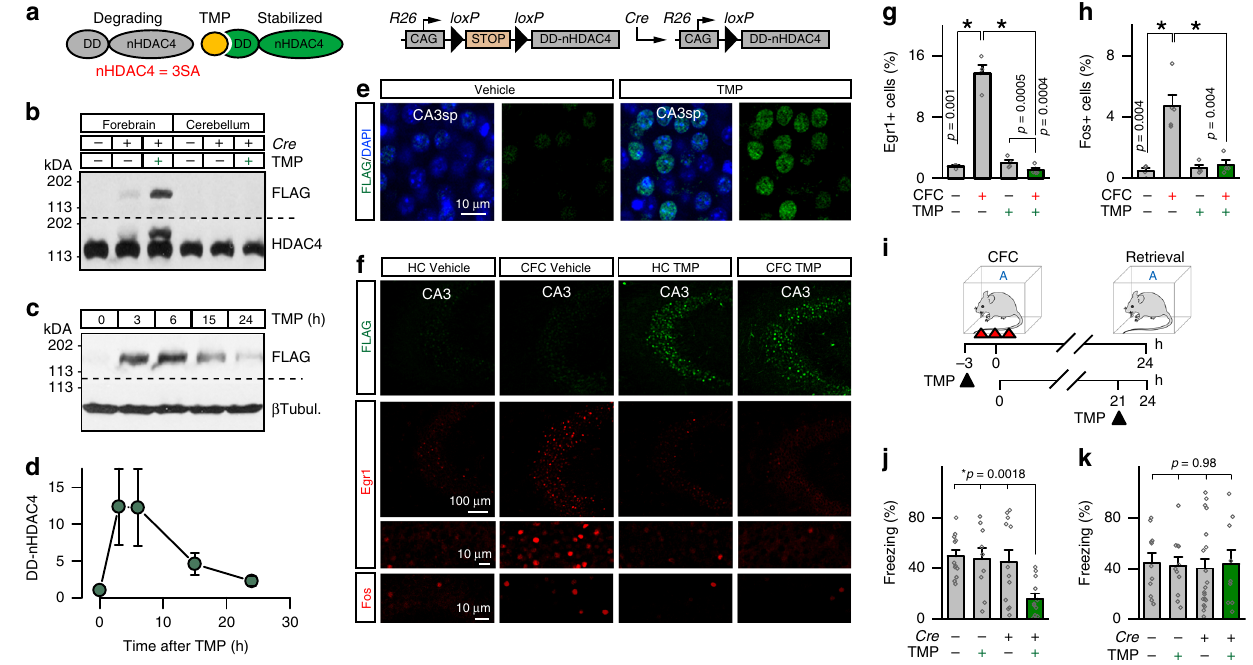
Fig. 6 Acute chemical-genetic control of nuclear repression with destabilized HDAC4. a Schematics of stabilization of DD-nHDAC4 protein with TMP and Rosa26 allele for Cre-dependent expression of DD-nHDAC4 form the CAG promoter ( R26 fl oxStop-DD-nHDAC4 ). See also Supplementary Fig. 8a. b – k DD- nHDAC4 was introduced into excitatory forebrain neurons by crossing R26 fl oxStop-DD-nHDAC4 mice with Camk2 α Cre . TMP-lactate (300 μ g/gm body weight) or control vehicle solutions were administered via intraperitoneal injections. b Brains were isolated at p60 3 h after drug delivery. Cortical and cerebellar protein extracts were probed by immunoblotting with antibodies against FLAG or HDAC4. c , d Time course of DD-nHDAC4 stabilization in the cortex. Immunoblot of samples isolated at different intervals after TMP injection ( c ) and quanti fi cations of DD-nHDAC4 levels ( d , r.u.) are shown. n = 3-4 mice/ time point. e Images of DD-nHDAC4 immuno fl uorescence in CA3sp of vehicle and TMP-treated R26 fl oxStop-DD-nHDAC4 / Camk2 α Cre mice (3 h post injection). See also Supplementary Fig. 8b. f – h Stabilized DD-nHDAC4 represses ERGs. R26 fl oxStop-DD-nHDAC4 / Camk2 α Cre mutants were given single doses of vehicle or TMP. Animals were maintained in home cages (HC) or subjected to CFC (3 h post-injection). After 1.5 h, brains were sectioned and labeled with antibodies against FLAG, Egr1, or Fos. Panels show images of the CA3 ( f ) and averaged densities of Erg1/Fos-positive cells in this area ( g , h ). See also Supplementary Fig. 8c. i – k Effects of TMP-inducible nuclear repression on associative memory. p60 R26 fl oxStop-DD-nHDAC4 / Camk2 α Cre and Cre-negative R26 fl oxStop-DD-nHDAC4 mice were treated with vehicle or TMP prior to CFC or prior to contextual memory retrieval, as depicted in i . j Freezing of animals that were given drugs 3 h before learning. Control + vehicle: n = 12; Control + TMP: n = 9; DD-nHDAC4 + vehicle: n = 12; DD-nHDAC4 + TMP: n = 12. k Freezing of animals that were given drugs 3 h before memory recall. Control + vehicle: n = 11; Control + TMP: n = 11; DD-nHDAC4 + vehicle: n = 19;